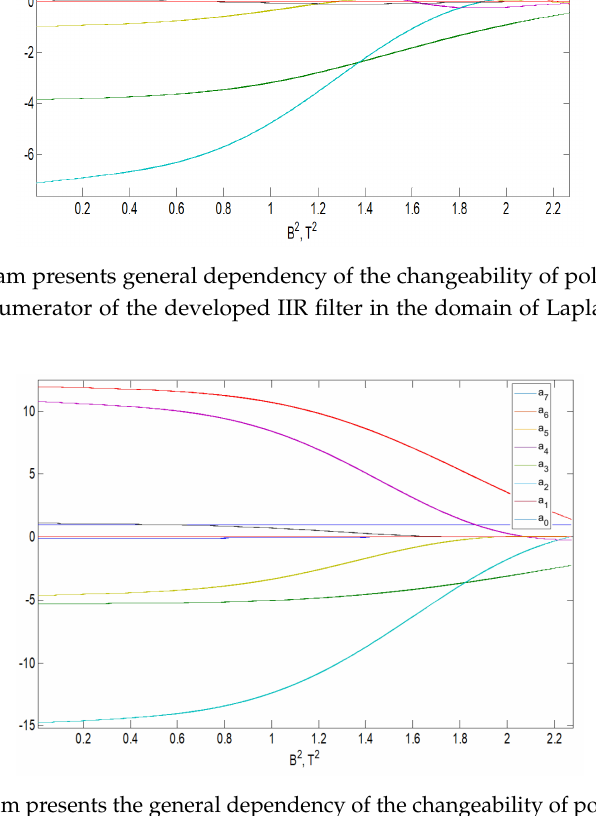
Figure 6. The diagram presents the general dependency of the changeability of polynomial coefficients that comprise the denominator of the developed IIR filter in the domain of the Laplace variable, s , in the function of B 2